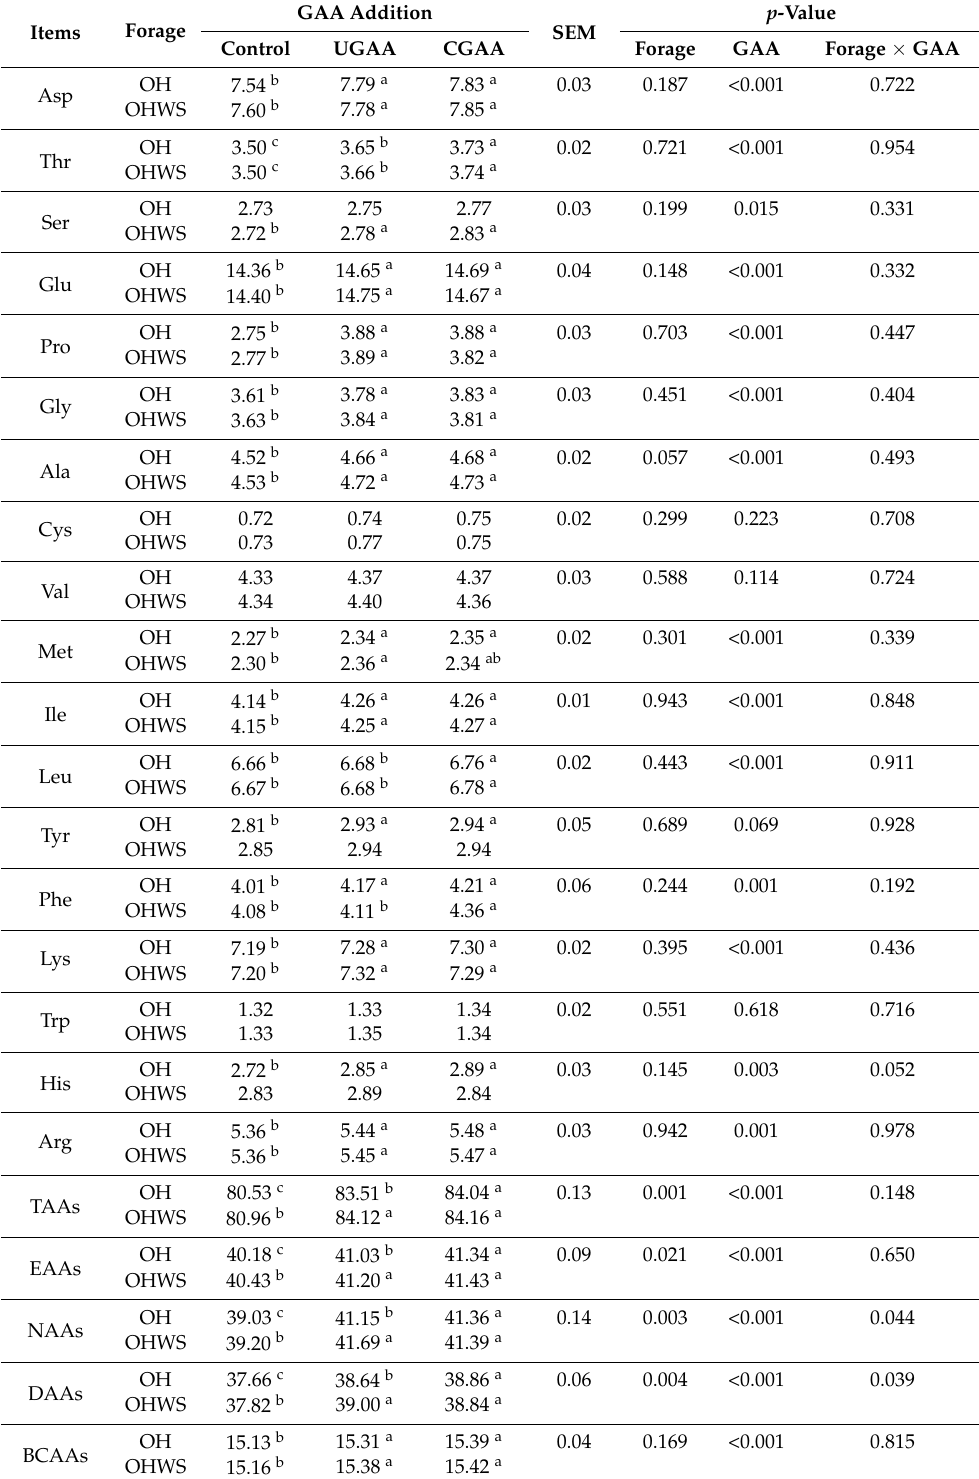
Table 7. Effects of forage type and GAA addition on the amino acid composition in longissimus lumborum of feedlotting